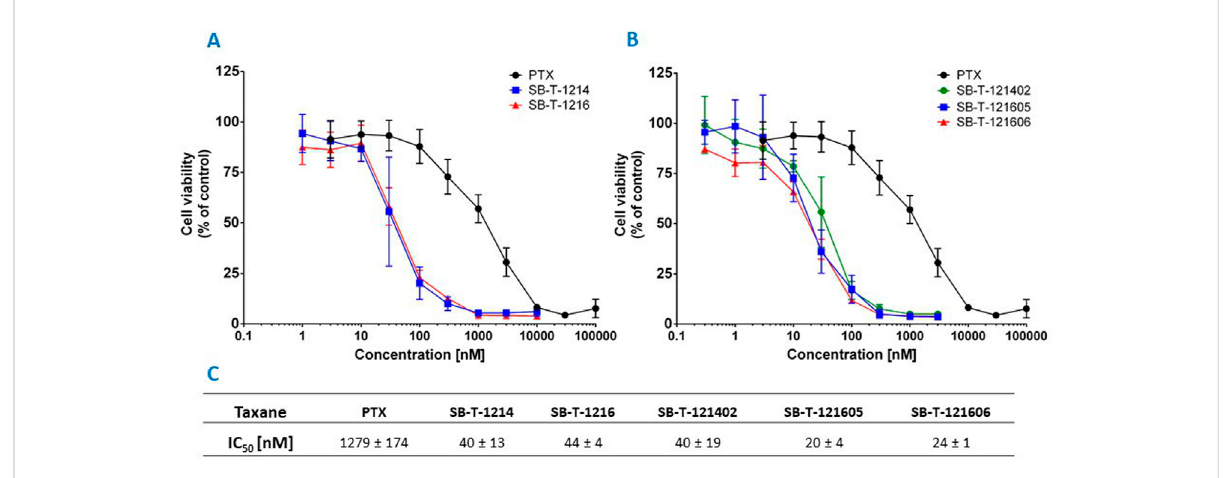
FIGURE 2 Graph representing the cell viability (% of control cells) of NCI/ADR-RES cells treated with PTX or (A) second generation or (B) third generation SB-Ts for 72 h. (C) Table of IC 50 values for studied taxanes. Mean ± S.D. of three independent experiments